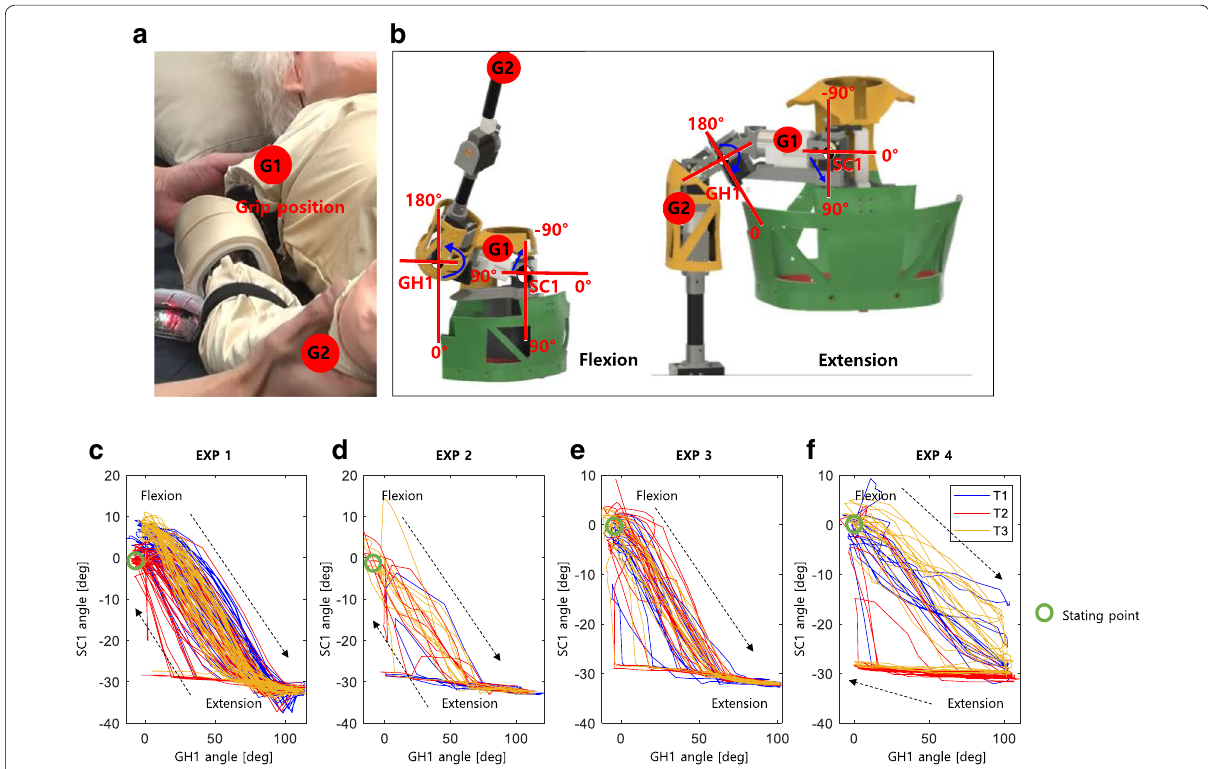
Fig. 9 Example of sterno‑clavicular and glenohumeral joints in extension and flexion (EF) exercise from the experts: a explanation of grip positions; b mechanism of elevation and depression; c angle curves between SC1 and GH2 joints. EXP expert, SC sterno‑clavicular joint, GH glenohumeral joint, Tn the number of tests. The green circle indicates the starting point of the